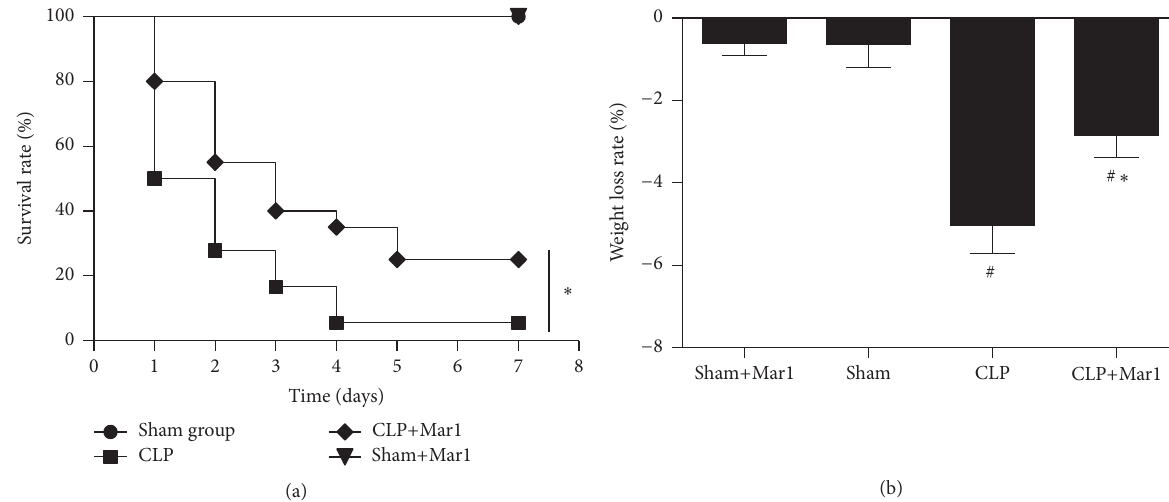
Figure 1: Improvement of survival rate ( 𝑛 = 20 ) and weight loss by Mar 1 in CLP mice. (a) Survival rate was significantly improved by Mar 1 administration. (b) Weight loss decreased with treatment of Mar 1. Survival rate was analyzed using the log-rank test. # 𝑃 < 0.05 versus the sham group. ∗ 𝑃 < 0.05 versus the CLP